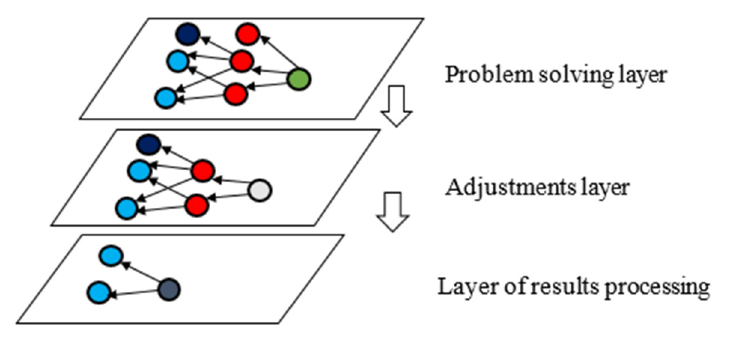
Figure 9. Problem-solving layers.